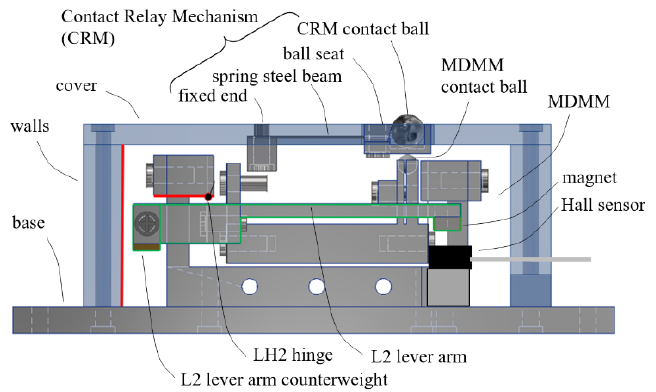
Figure 28. Design of the packaging and the Contact Relay